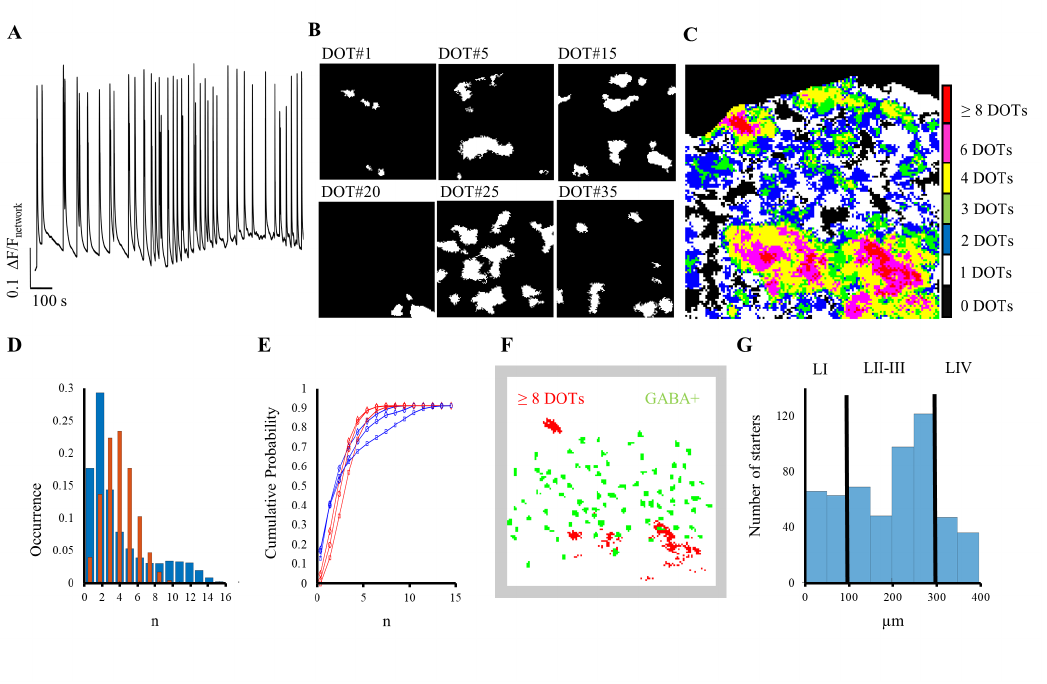
Figure 3: Regions initiating DOTs in cortical slices. (A) ΔF/F network of a representative 20 min recording. (B) Binary images of some representative seeds regions identified 200 ms before 6 randomly selected DOTs (out of a total of 35). (C) Sum of all binary images corresponding to seeds; different colors indicate regions activated before multiple DOTs (see color bar on the right: red regions are activated before the onset of 8-11 DOTs). (D) Probability of activation of a pixel from experimental data (red bars) compared to a binomial distribution (blue bars) in the experiment shown in A - C. The x-axis represents the number of trials (frames) considered. (E) Cumulative probability of pixel activation from experimental data (blue lines) compared to the corresponding binomial distributions (red lines) in three representative experiments. The two distributions were significantly different (p < 0.001 two-sample Kolmogorov-Smirnof test). (F) Regions activated before the occurrence of 8 - 11 DOTs (red pixels) in the example shown in A - C, with reference to the location of GABA+ neurons (green pixels). (G) Distribution of starters location among cortical layers. n = 7 slices. The density is higher between LII and